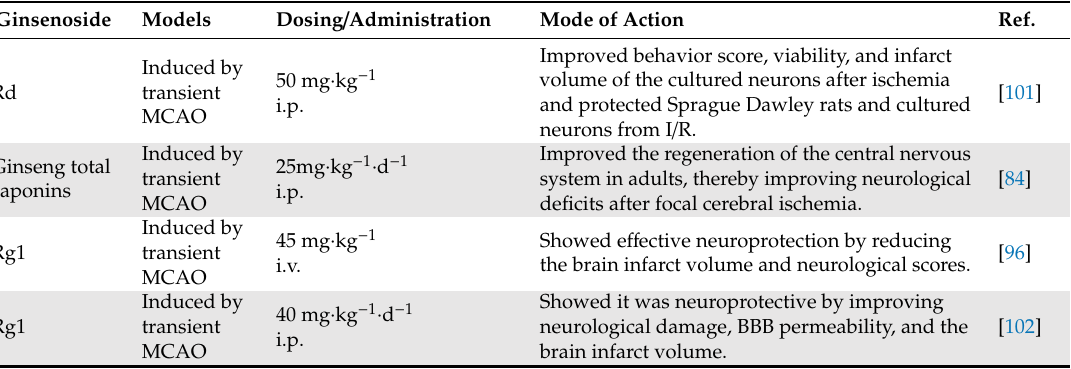
Table 2. The ginsenoside experimental method for treating I /